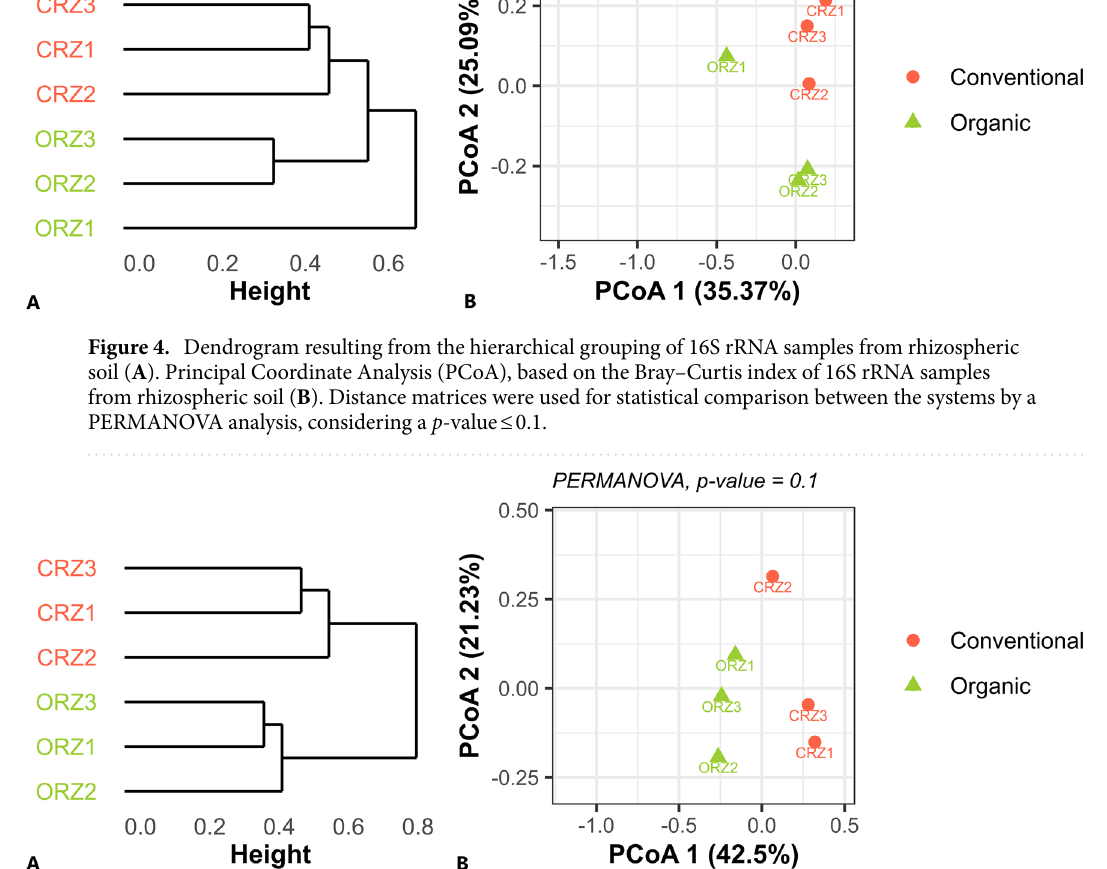
Figure 5. Dendrogram resulting from the hierarchical grouping of ITS samples of rhizospheric soil ( A ). Principal Coordinate Analysis (PCoA), based on the Bray–Curtis index of ITS samples of rhizospheric soil ( B ). Distance matrices were used for statistical comparison between the systems by a PERMANOVA analysis, considering a p -value ≤